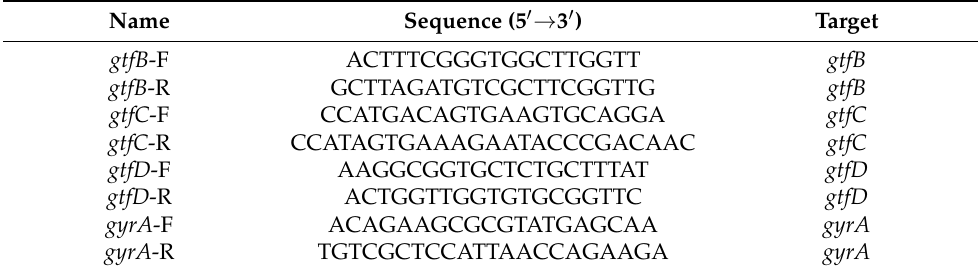
Table 1. Primers used in this